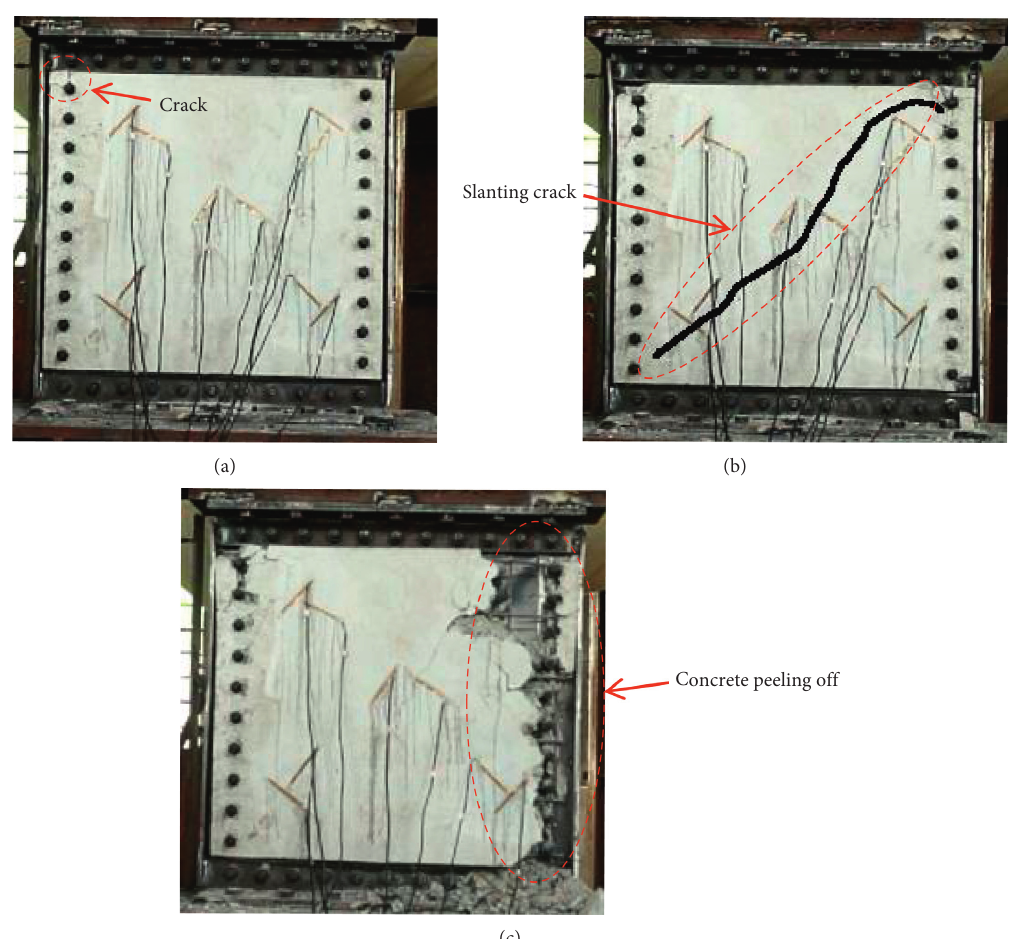
Figure 13: Deformation of BRSPSW specimen under different loading displacements. (a) 24mm. (b) 38mm. (c) Final state of